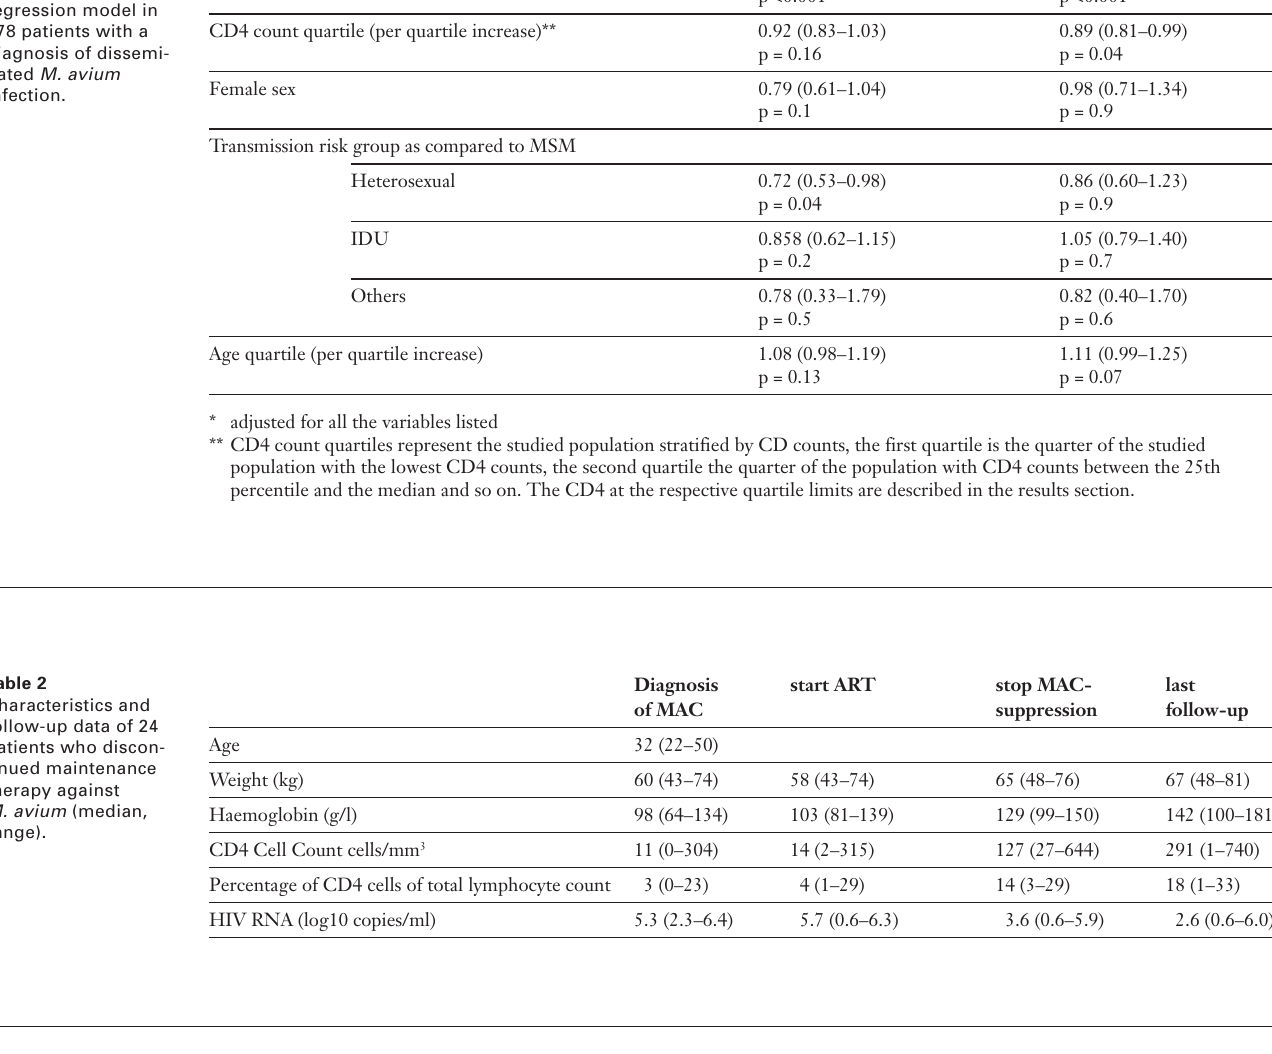
Hazard ratio of death according to a Cox proportional hazards regression model in 378 patients with a diagnosis of dissemi- nated M. avium infection.